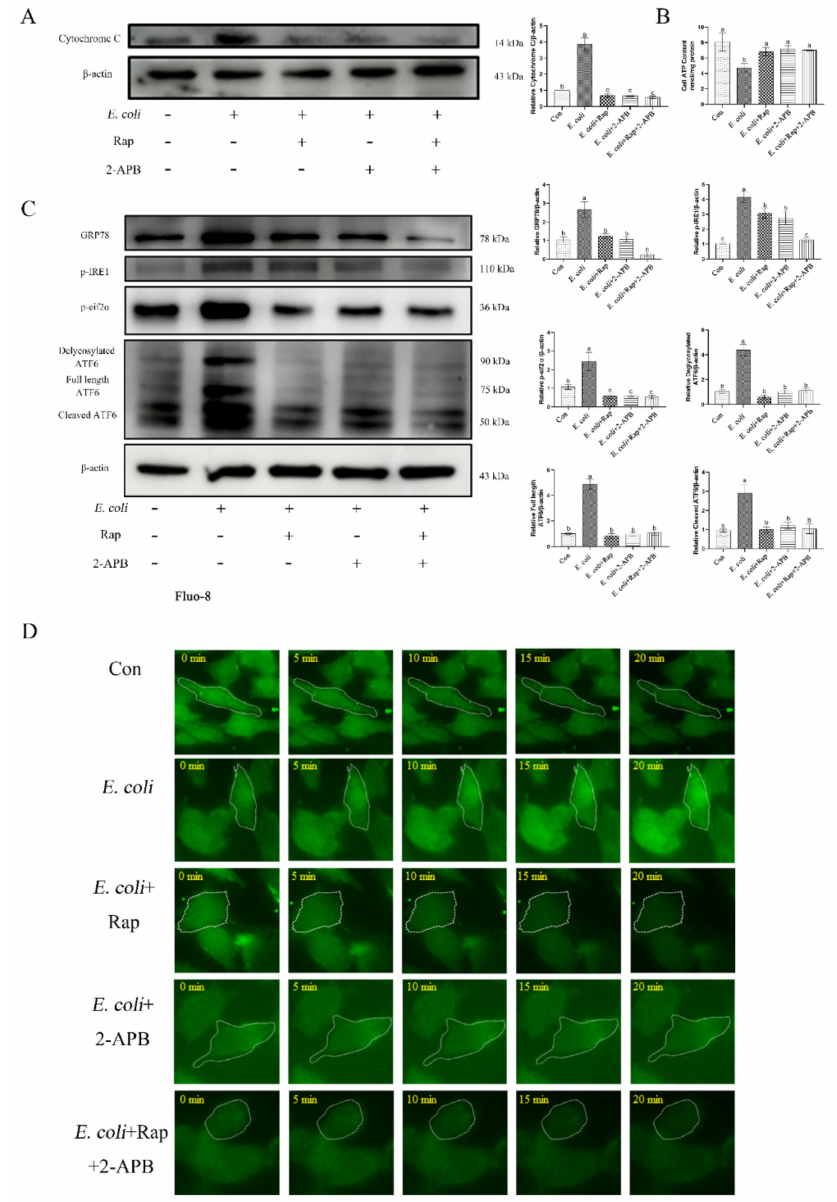
Figure 9. Enhancement of autophagic activity with 2-APB and rapamycin improves E. coli -induced damage response. Primary bEECs were either uninfected or infected with E. coli for 6 h after pretreatment with rapamycin (10 µ M) or 2-APB (50 µ M). ( A ) Western blot analysis of cytochrome c levels. ( B ) ATP content was detected by an ATP assay kit. ( C ) The expression of ERS-related proteins (GRP78, p-IRE1, p-eif2 α , and ATF6) was measured by Western blot. ( D ) Fluo-8 AM was used to monitor cytosolic Ca 2+ levels in real time. Cells were exposed to E. coli for up to 20 min. Con, no infection control. The data are means ± SEM of three independent experiments. Bars with different letters indicate significant differences ( p <